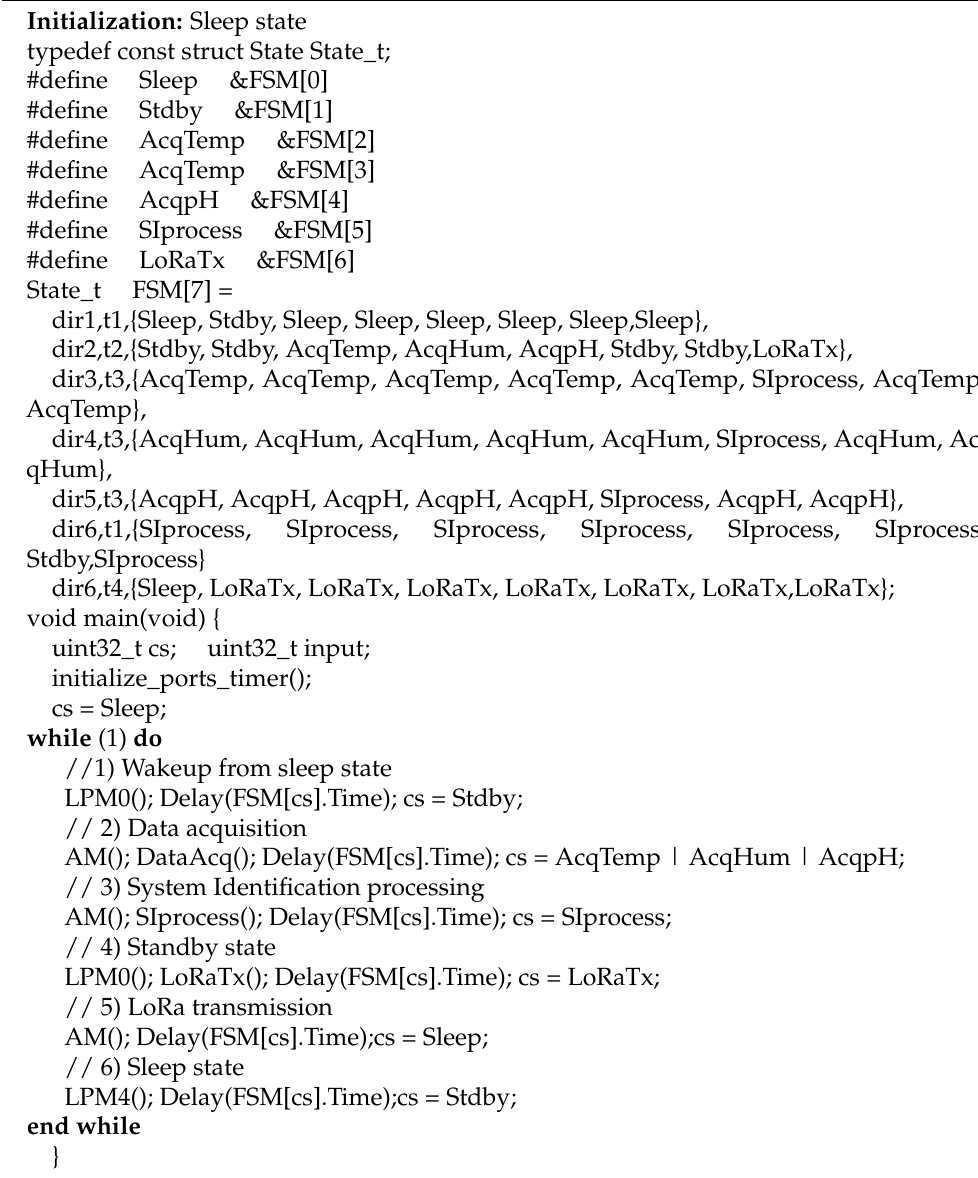
Algorithm 1 FSM pseudo-code of the power